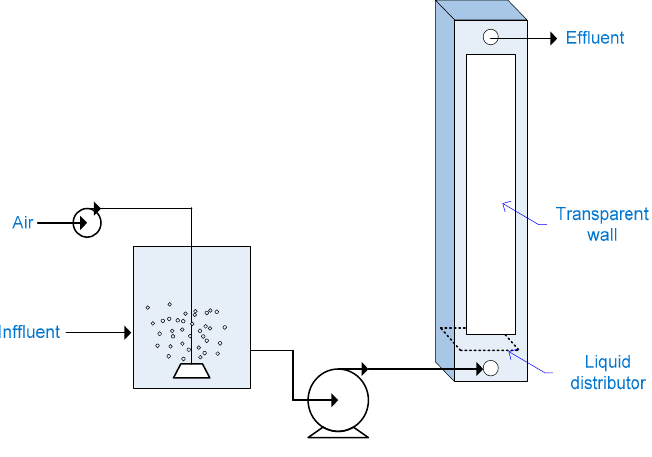
Figure 8. Schematic drawing of flat plate column reactor.